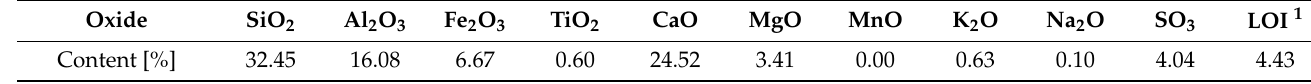
Table 3. Chemical composition of the used